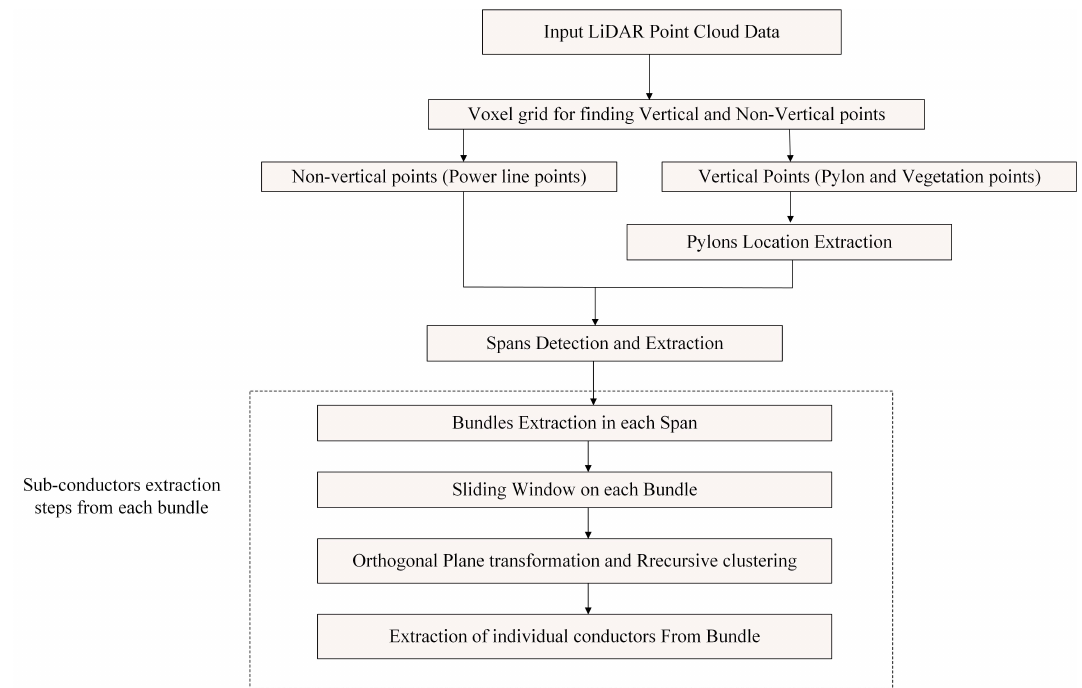
Figure 1. Processing flowchart of the proposed